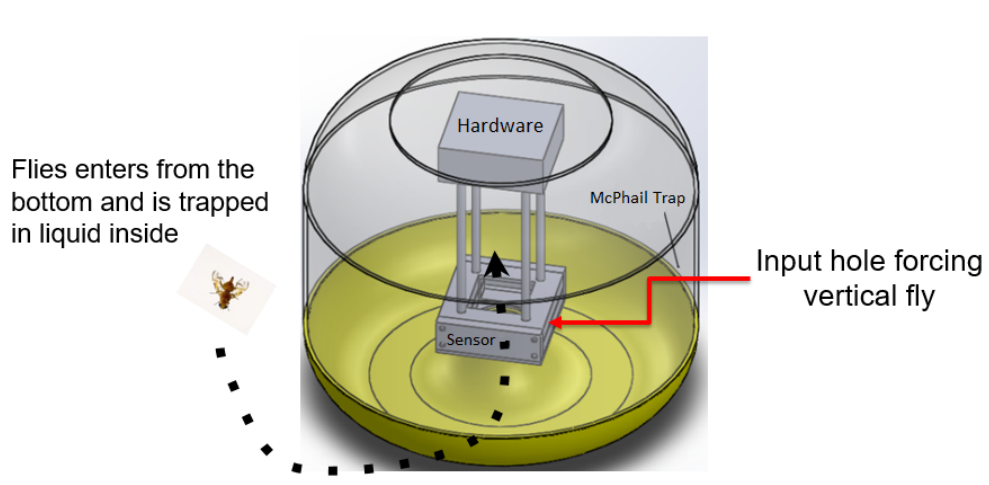
Figure 4. Proposal of a McPhail intelligent trap using the developed sensor optoelectronic sensor.